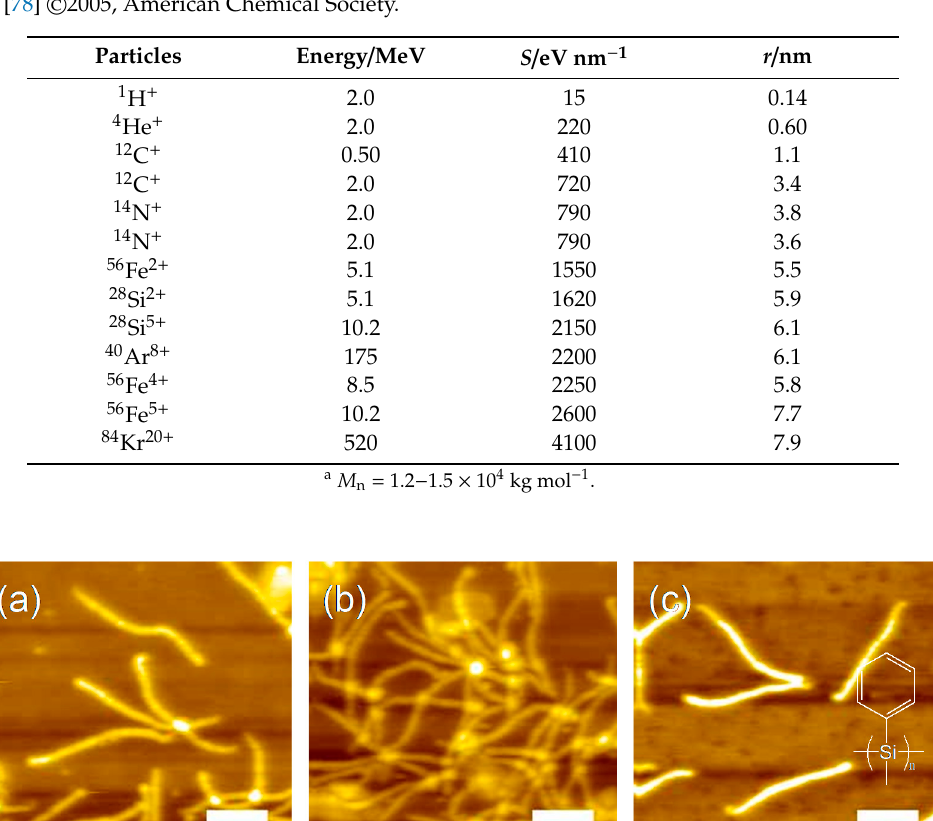
Table 1. Values of r observed in polysilane a upon irradiation to various particles. Data quoted from ref. [78] © 2005, American Chemical Society.